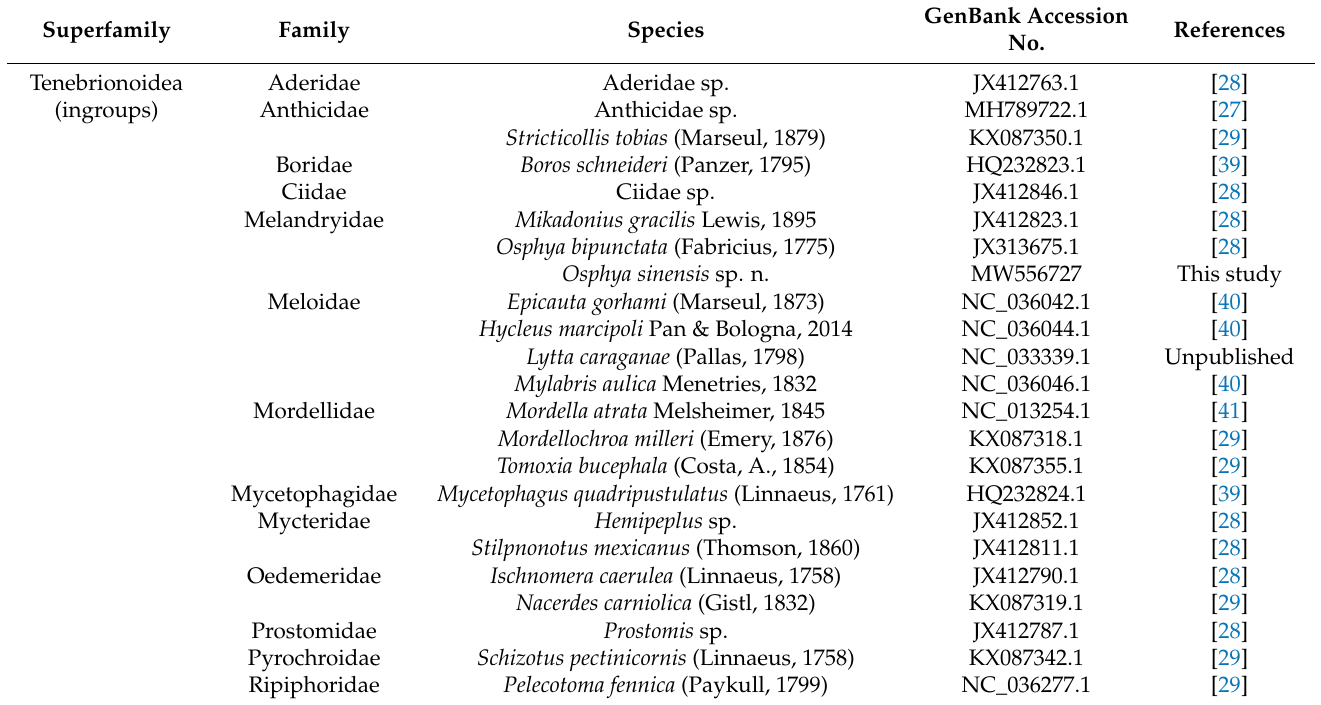
Table 1. Sequence information used in the phylogenetic